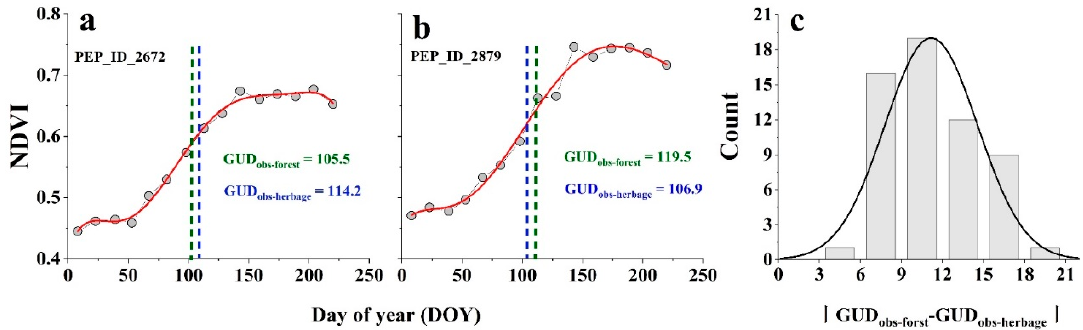
Figure 1. Multi-years average value of normalized difference vegetation index (NDVI) time-series data and the observed green-up date (GUD) (Green dash line for deciduous forest and blue dash line for herbage, respectively) in site PEP_ID_2672 ( a ) and site PEP_ID_2879 ( b ) of the Pan European Phenology (PEP) Database. The red line is the fitted curve based on the six-degree polynomial function (Equation (1)). The frequency histogram ( c ) shows the multi-year average difference values of observed GUD between deciduous forest (GUD obs-forest ) and herbage (GUD obs-herbage ) in the selected forest-herbage-mixed (FHM) sites in our study.